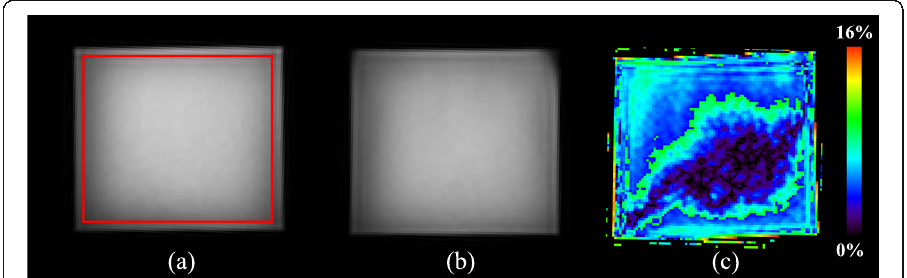
Fig. 6 Dixon MR images with no DP-PET ( a ) and DP-PET inserted ( b ), and c is the result of subtracting a and